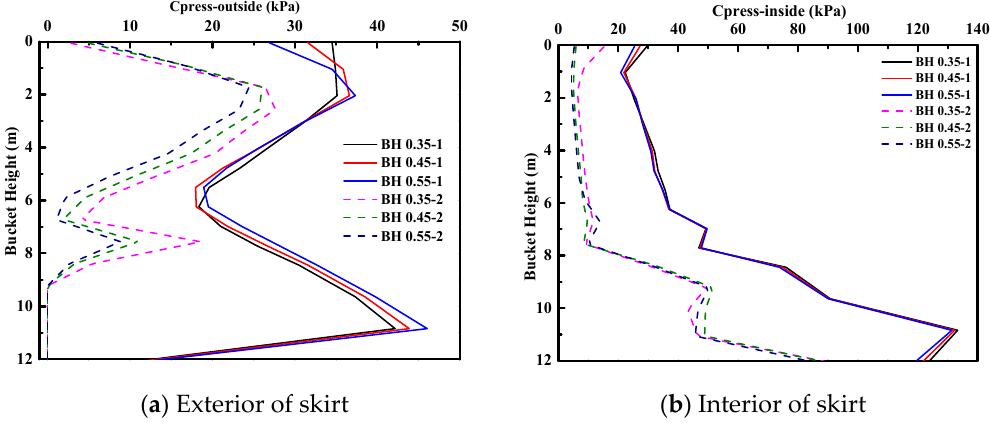
Figure 13. Contact stress of skirt under different friction coefficients.